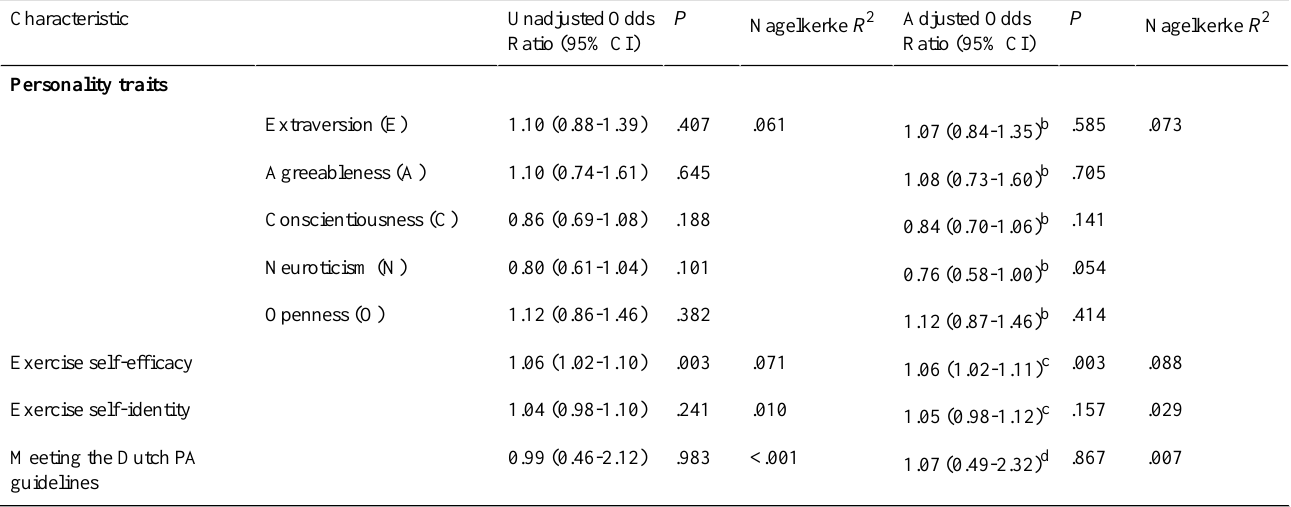
Table 5. Association between personality traits and a high preference for behavior change techniques addressing feedback and self-monitoring a